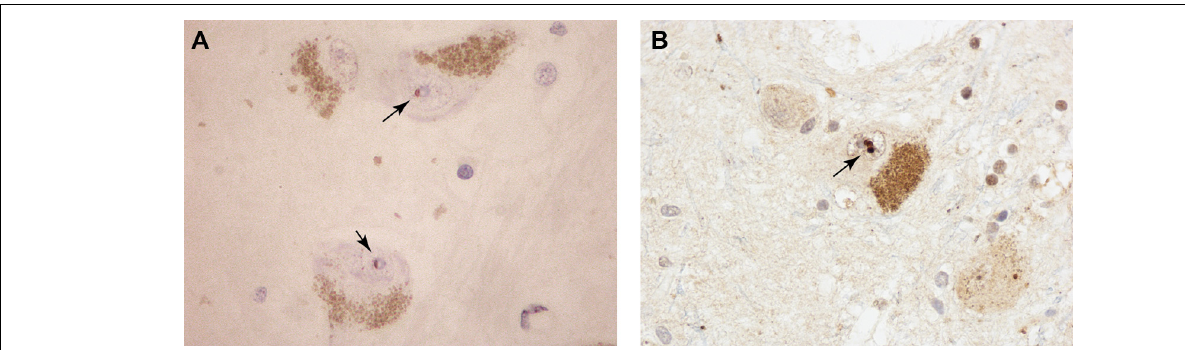
FIGURE 2 | Pigmented dopaminergic neurons in the substantia nigra from aged, non-diseases subjects containing intranuclear MBs (arrows) immunoreactive for promyelocytic leukemia protein (PML;A) and ubiquitin (B).